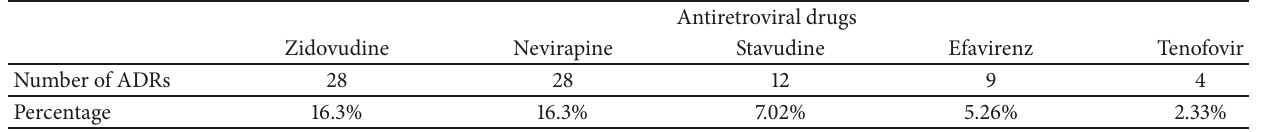
(a) Antiretroviral drugs and ADRs Antiretroviral